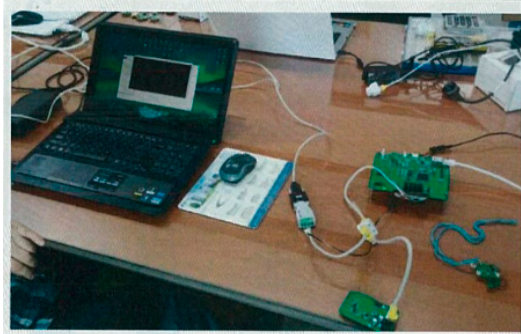
Figure 18. Configuration of testing device for RSSI.